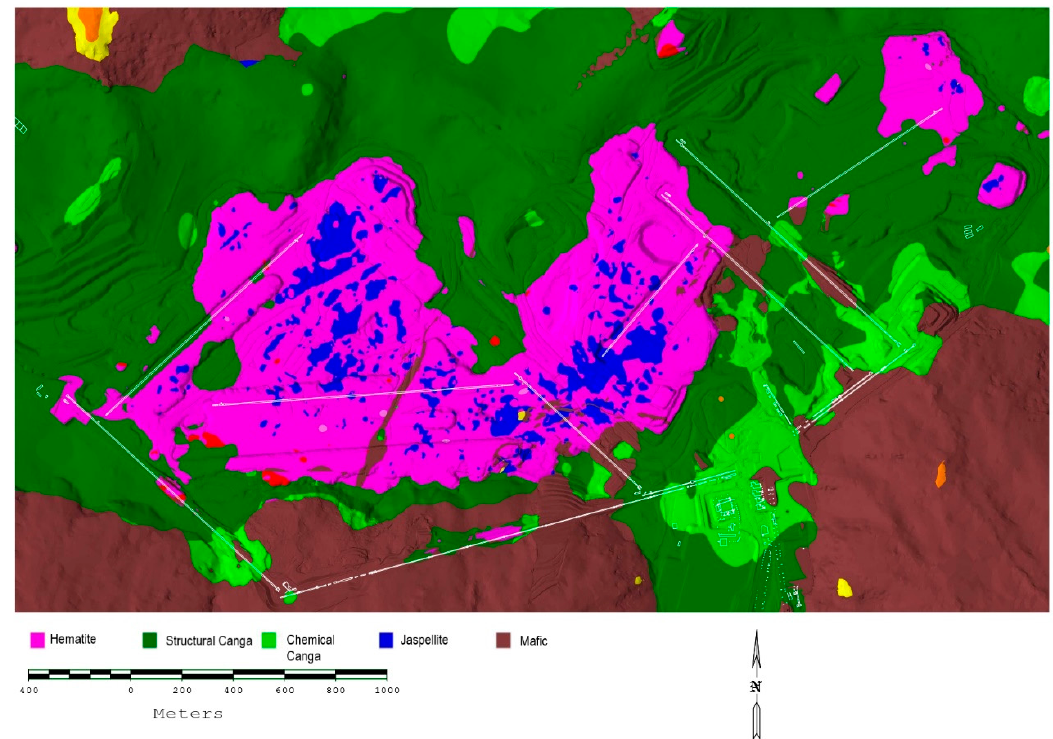
Figure 2. Main lithologies of the truckless mine.